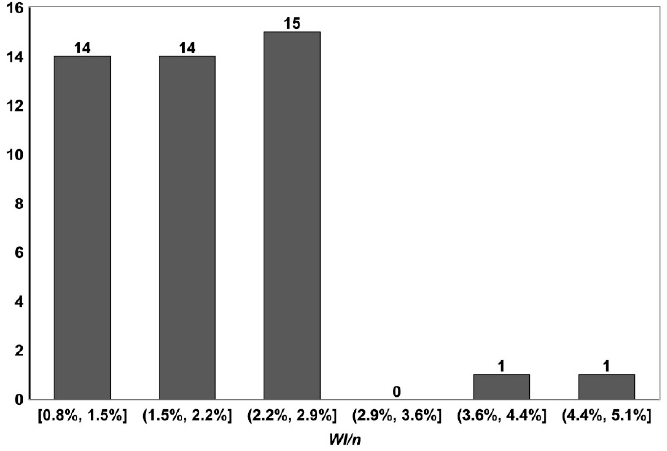
Figure 5. Histogram of WI/n values for 23 buildings (based on two WI/n values per building).